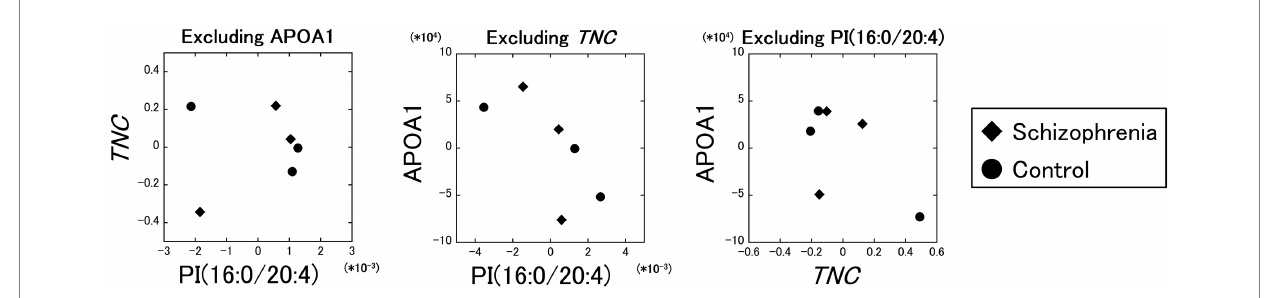
FIGURE 4 Partial correlation analyses between the PI (16:0/20:4), the TNC gene, and the APOA1 protein. The partial correlation between the PI (16:0/20:4) and the TNC gene, excluding the influence of the APOA1 protein, was comparatively poor ( r = 0.11). The partial correlations between the PI (16:0/20:4) and the APOA1 protein excluding the influence of the TNC gene ( r = − 0.71), and between the TNC gene and the APOA1 protein excluding the influence of the PI (16:0/20:4) ( r = − 0.60) were comparatively strong. Diamonds: samples from schizophrenia patients. Circles: samples from control